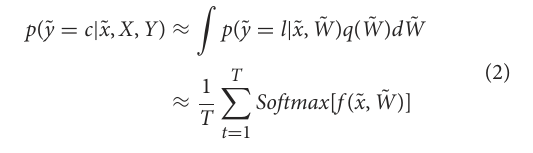
image ˜ x can be expressed as p ( ˜ y |˜ x ) = Softmax [ f ( ˜ x ; W )].